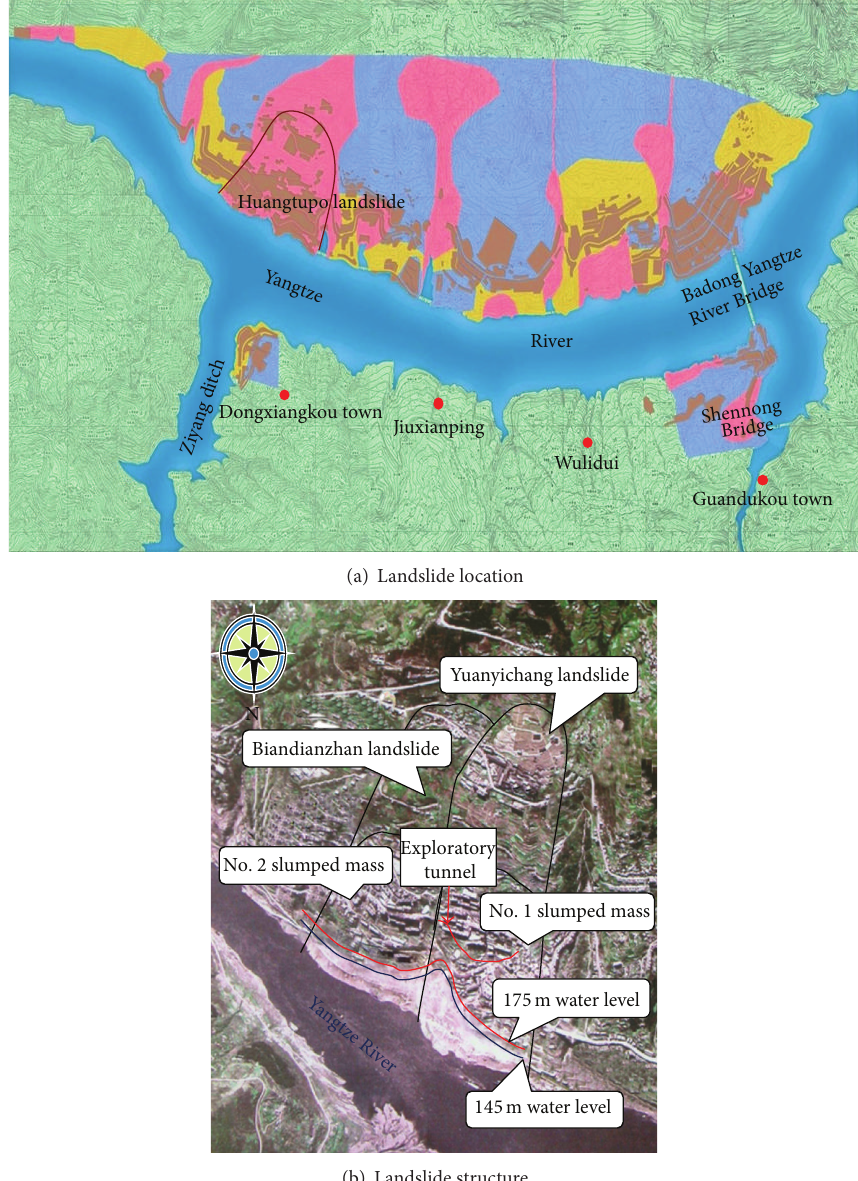
Figure 1: Huangtupo landslide.